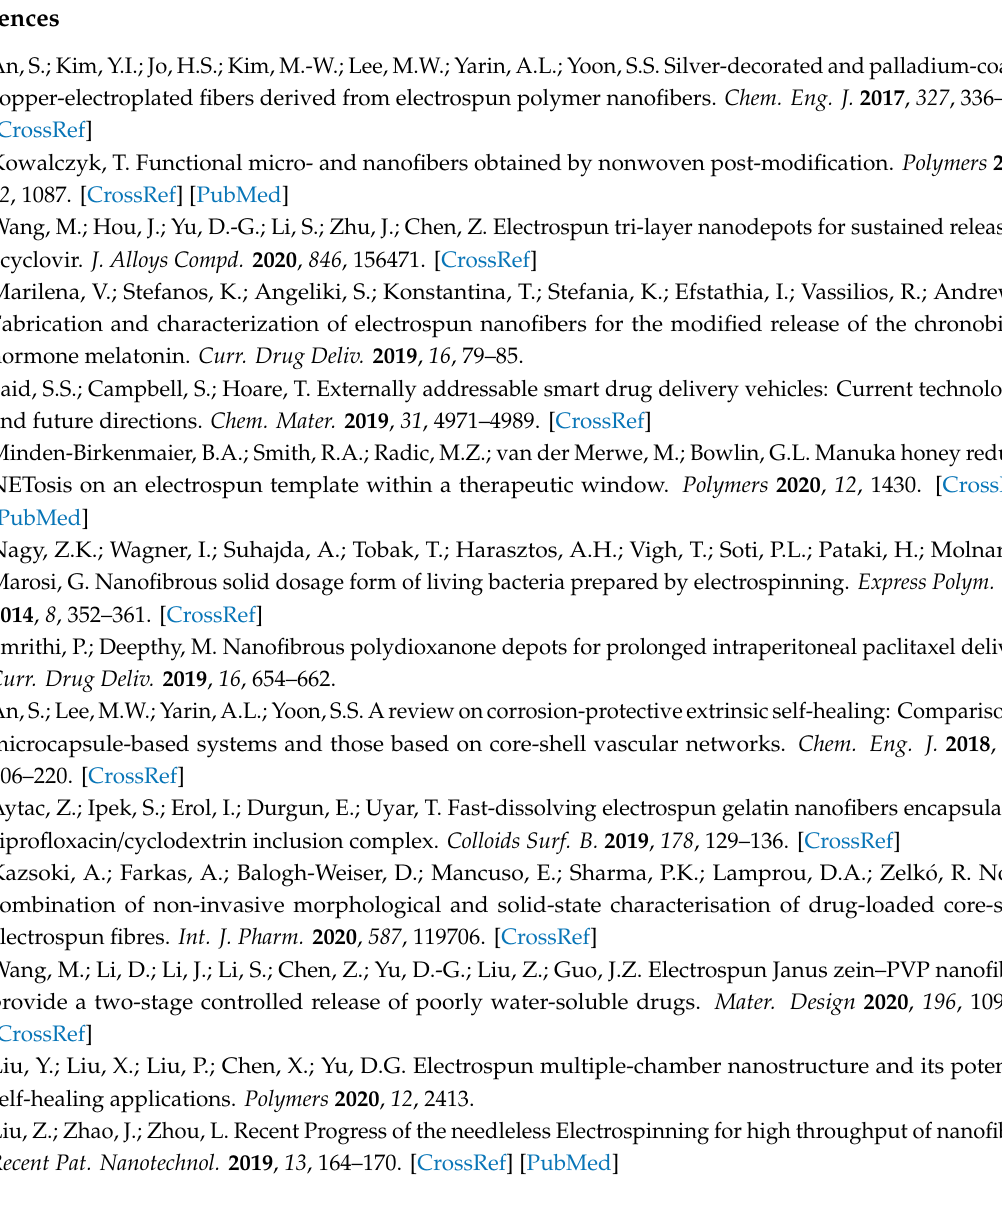
Figure S1: Polarized microscopic images of the EHDA products from working fluids with varied PVP and KET concentrations, which were created using the coaxial spinneret with a core solid Teflon rod: (a) E1; (b) E2; (c) N2; (d) E3; (e) E4; (f) E5. Figure S2: Observations of the fast disappearance of a drop of water when it is placed on the surface of electrospun nanofibers N1. Figure S3. Observations of the fast disappearance of a drop of water when it is placed on the surface of electrospun nanofibers N2. Table S1: The parameters for EHDA processes on di ff erent working